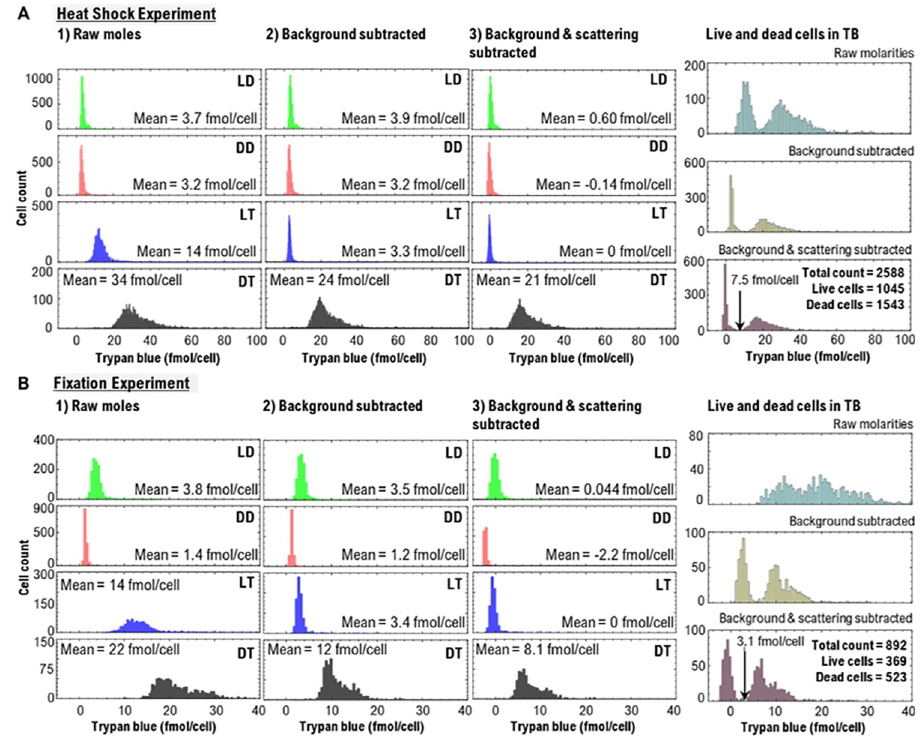
Fig 6. Determination of intracellular trypan blue (TB) content (mol/cell) using absorbance images. Absorbance microscopy output data for (A) heat-shock and (B) fixation experiments illustrating the histograms of the intracellular moles of TB using three different image processing strategies: 1) ‘Raw moles,’ 2) ‘Background subtracted,’ and 3) ‘Background & scattering subtracted.’ The far-right column reveals the live and dead cell counts for the control ‘Live and dead cells in TB’ experiment, where an equal number of live and dead cells were mixed in TB+DPBS solution. The arrow in the far-right column denotes the calculated threshold using LT and DT samples using image processing strategy #3. The threshold is used to calculate live cells (cells below the threshold) and dead cells (cells above the threshold). Abbreviations: LD = live cells in Dulbecco’s phosphate-buffered saline (DPBS) solution, LT = live cells in trypan blue (TB) solution mixed with DPBS at a 1:4 (TB:DPBS) ratio, DD = dead cells in DPBS, and DT = dead cells in TB solution mixed with DPBS at a 1:4 ratio (TB:DPBS). The histograms in panels (A) and (B) show that the intracellular uptake of TB is different depending on the cell-killing